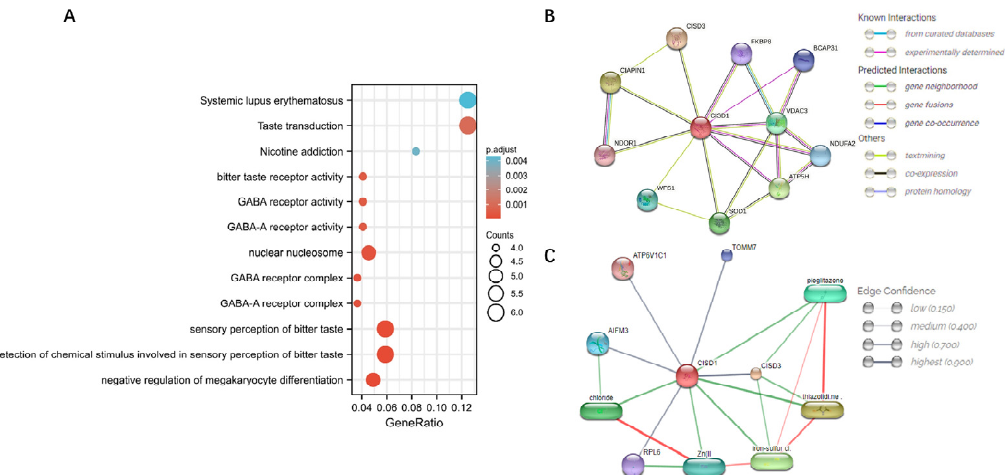
Figure 4. Co-expressed genes enrichment and interaction analysis. Co-expressed genes with CISD1 enrichment analysis ( A ), protein-protein interactions ( B ), and chemical-protein interactions ( C ) showed. Stronger associations represented by thicker lines. Chemical-protein interactions in green and interactions between chemicals in red.